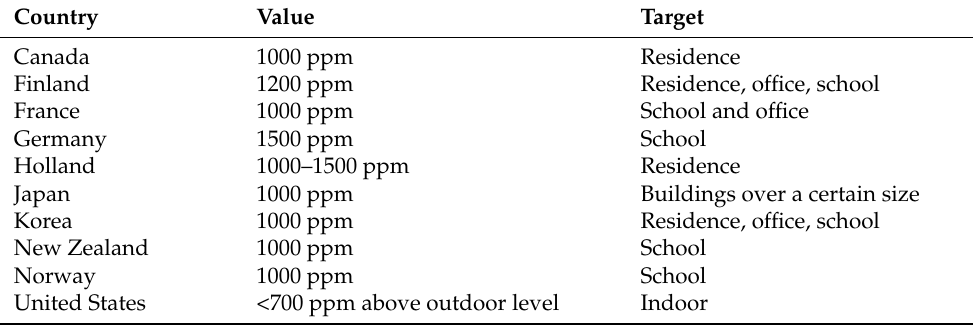
Table 1. CO 2 concentration standards and guidelines in each country